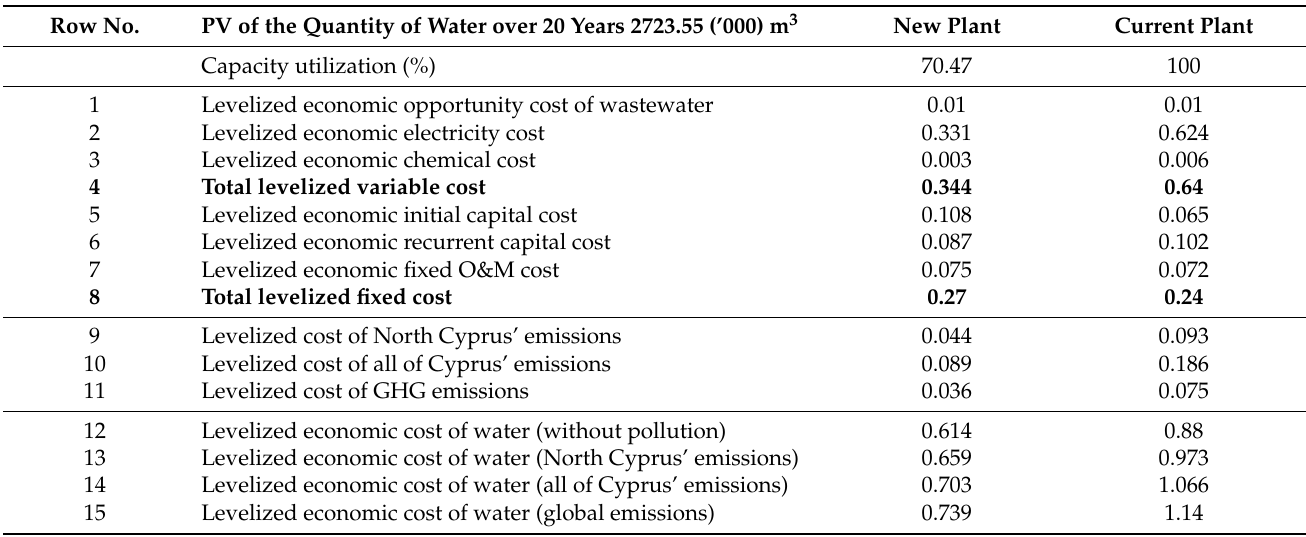
Table 14. Levelized economic costs (with diesel fuel generators) for the different levels of utilization (in 2022 prices), USD/m 3